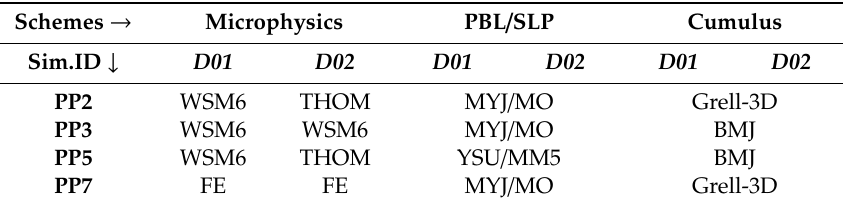
Table 1. Parameterization combinations of the WRF model. The four di ff erent simulations are named as PP2, PP3, PP5 and